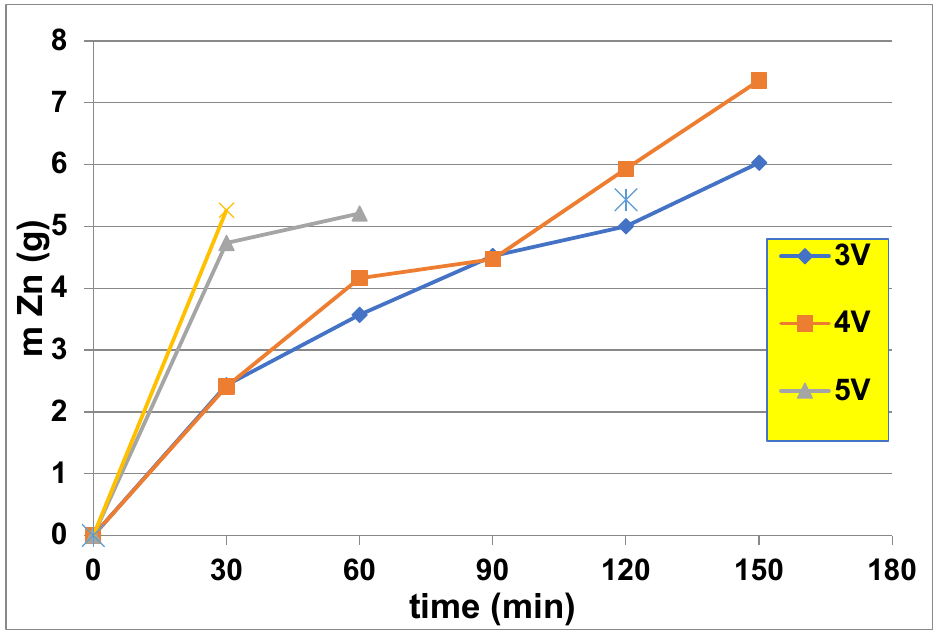
Figure 12. An influence of the electric voltage of the electrolytic cell upon the efficiency of the cathode zinc obtaining.